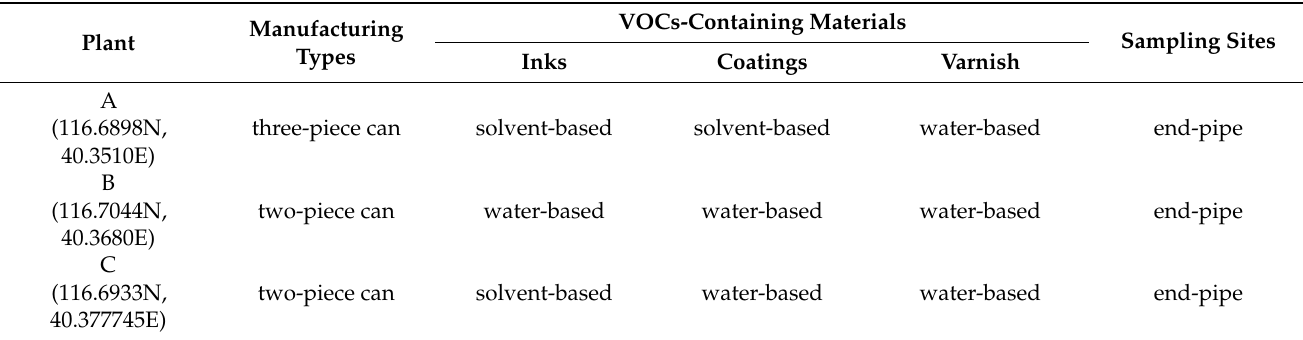
Table 1. Sampling information of the three